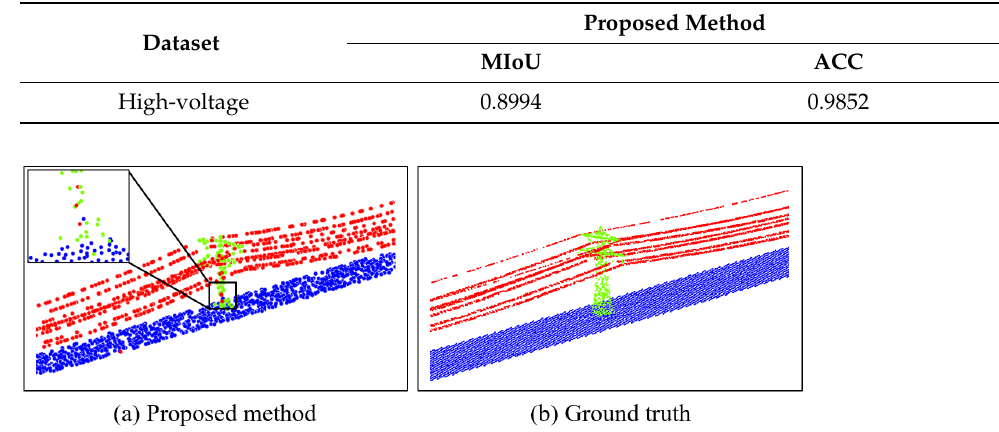
Table 9. MIoU and ACC of the proposed method in a high-voltage powerline scenario.